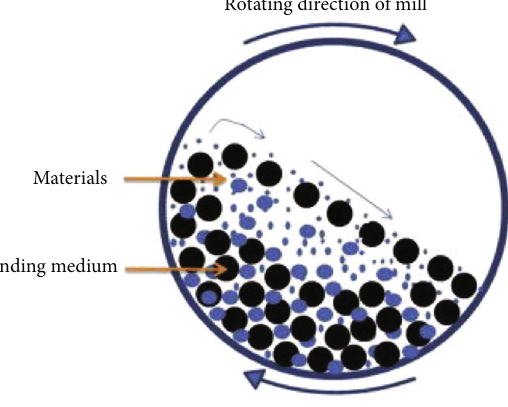
Figure 5: Ball mill machine